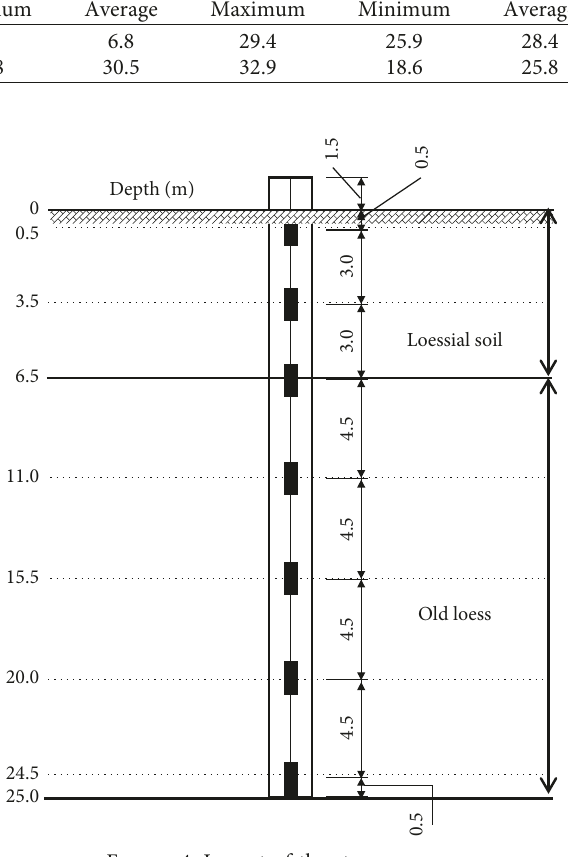
Figure 4: Layout of the stress